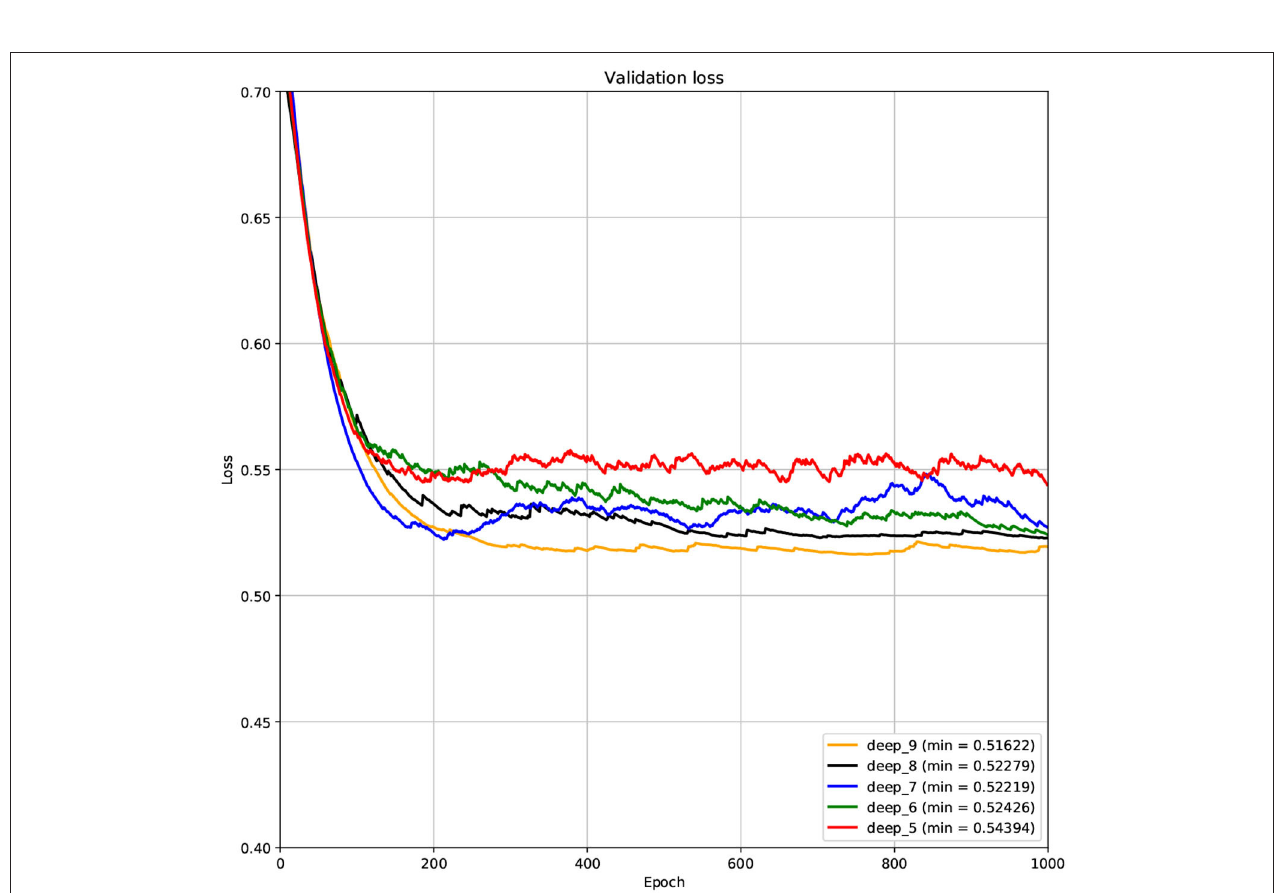
FIGURE 6 | The variation curve of the validation loss.